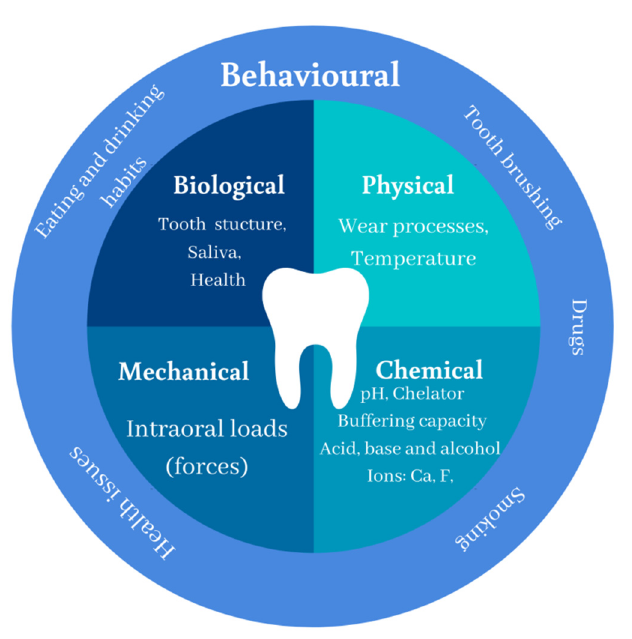
Figure 1. Characteristic of oral environment divided into four main groups: chemical, mechanical, biological, and physical factors. *Behavioural aspects affect individual factors.